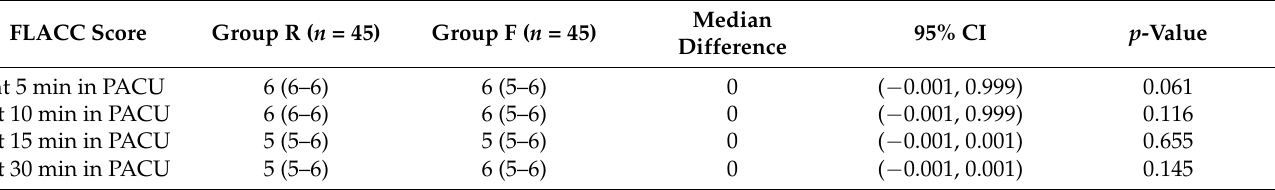
Table 4. Face, legs, activity, cry, and consolability (FLACC) scores.